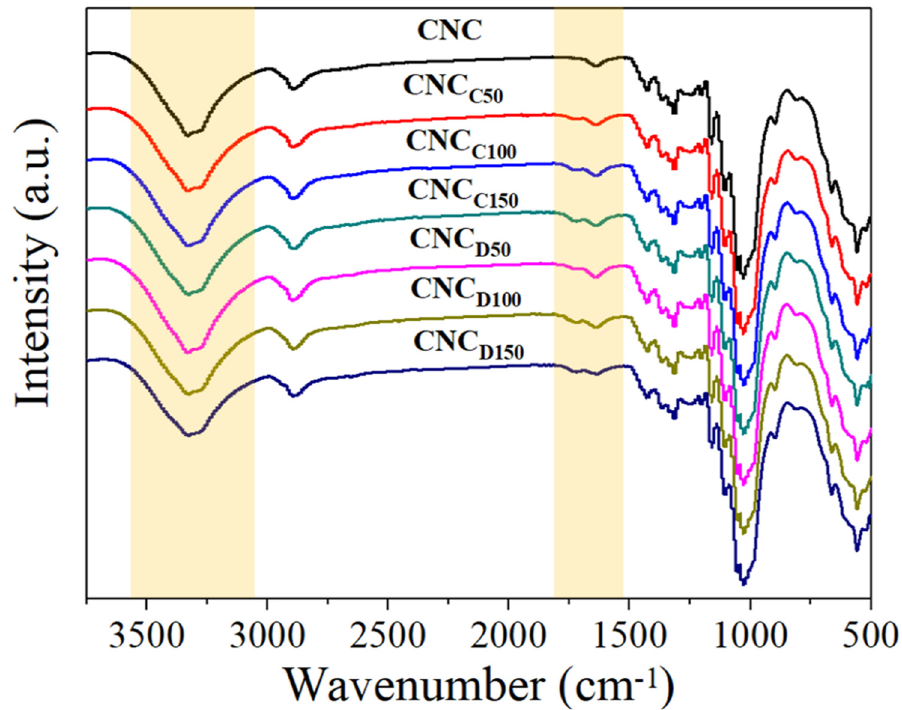
Figure 2. FTIR spectra of CNC modified with ε -caprolactone and δ -decalactone by plasma-induced polymerization.